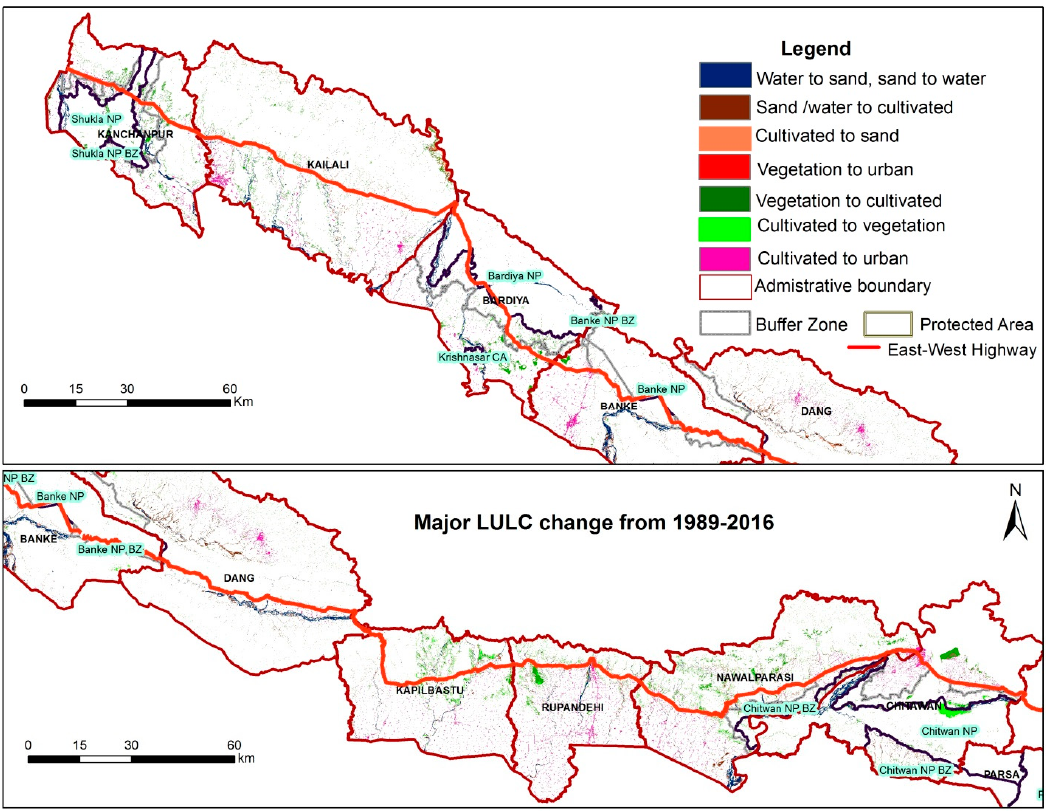
Figure 4. Observed land-use/cover transitions for the western Tarai study area,